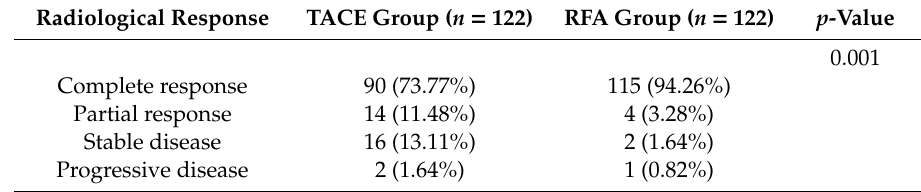
Table 4. Radiological response according to the treatment modality after adjustment through PS-matching.